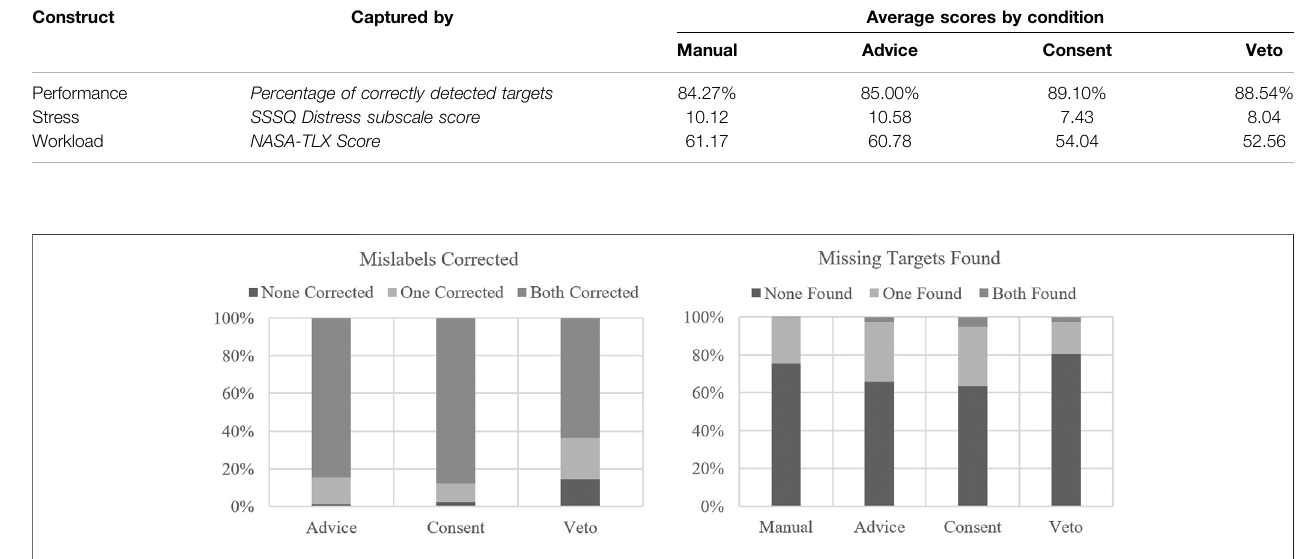
TABLE 3 | Mission performance scores by condition.